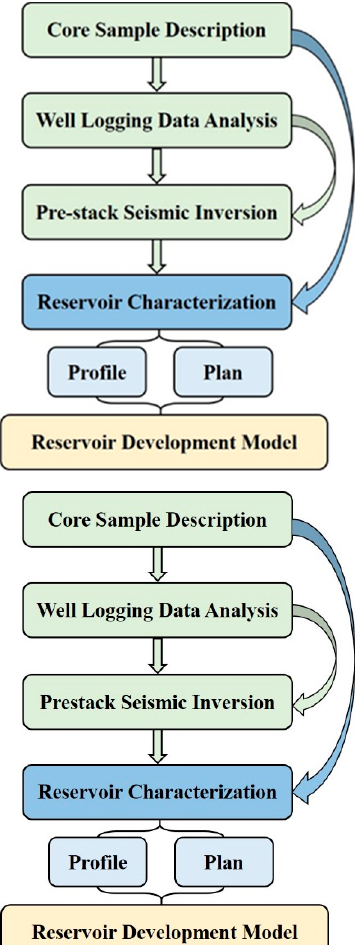
Figure 3. Technology roadmap for this research.